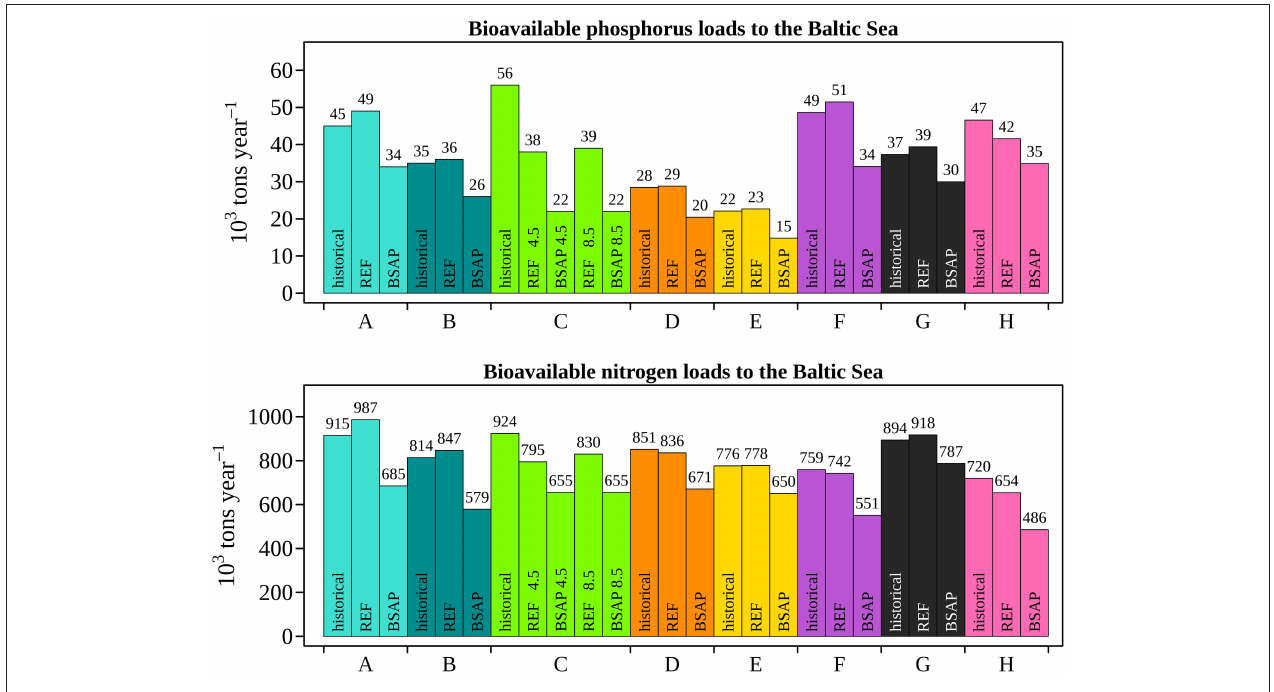
FIGURE 3 | Projected ensemble means of total (land and atmosphere) bioavailable annual nutrient loads (phosphorus–upper panel, nitrogen–lower panel) to the Baltic Sea in historical (1980–2005) and future (2072–2097) climates for the scenarios REF and BSAP. At the x-axis the scenario simulations of Model A to H are listed (with a color code as in the other figures of this study). Note that for Model C projections driven by both RCP 4.5 and RCP 8.5 are shown. Model A (RCO-SCOBI coupled to STAT), B (RCO-SCOBI coupled to B-HYPE), C (RCO-SCOBI coupled to E-HYPE), D (ERGOM coupled to STAT), E (ERGOM2 using data), F (BALTSEM coupled to STAT), G (PROBE-Baltic coupled to CSIM), and H (SPBEM coupled to